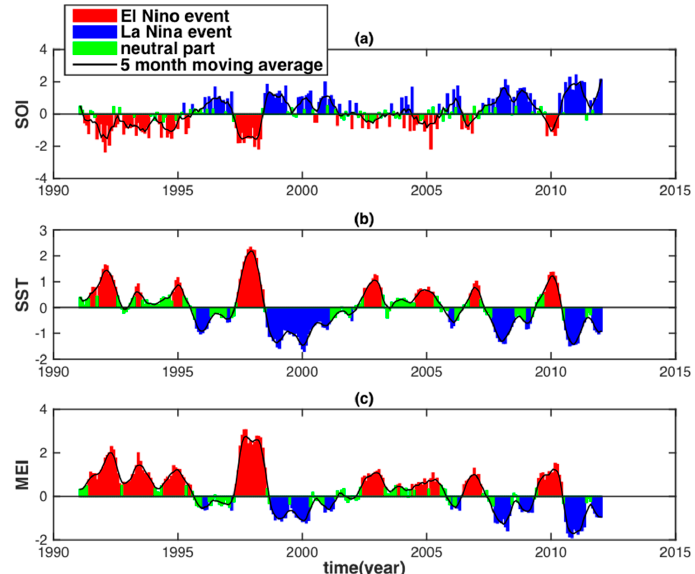
Figure 3. Time series of SOI ( a ), SST anomalies in the Niño 3.4 region ( b ) and MEI ( c ). Red, blue and green bars indicate El Niño events, La Niña events and neutral parts, respectively.